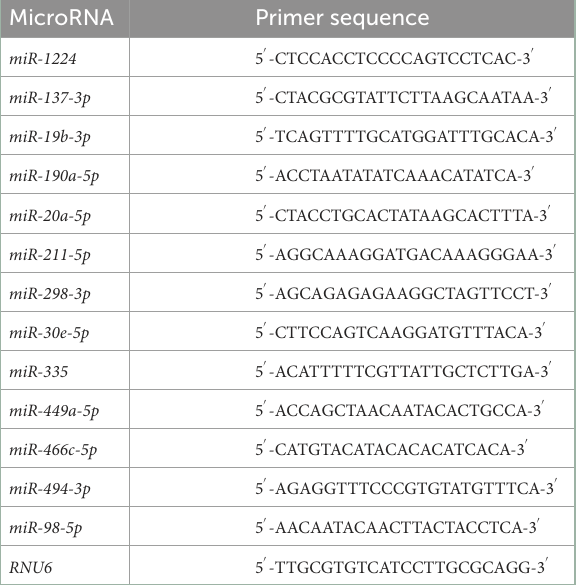
TABLE 2 MicroRNA primers for quantitative real-time